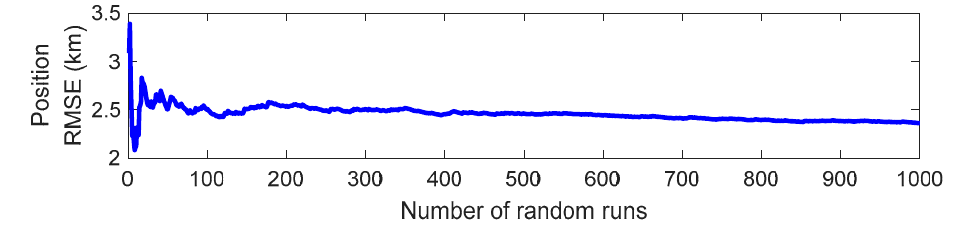
Figure 3. Convergence of the position root mean square error (RMSE) of Target 2 obtained by Newton–Raphson particle swarm optimization (NRPSO), in which 600 bearing measurements corrupted by measurement noise with a standard deviation of 1.9° were used.